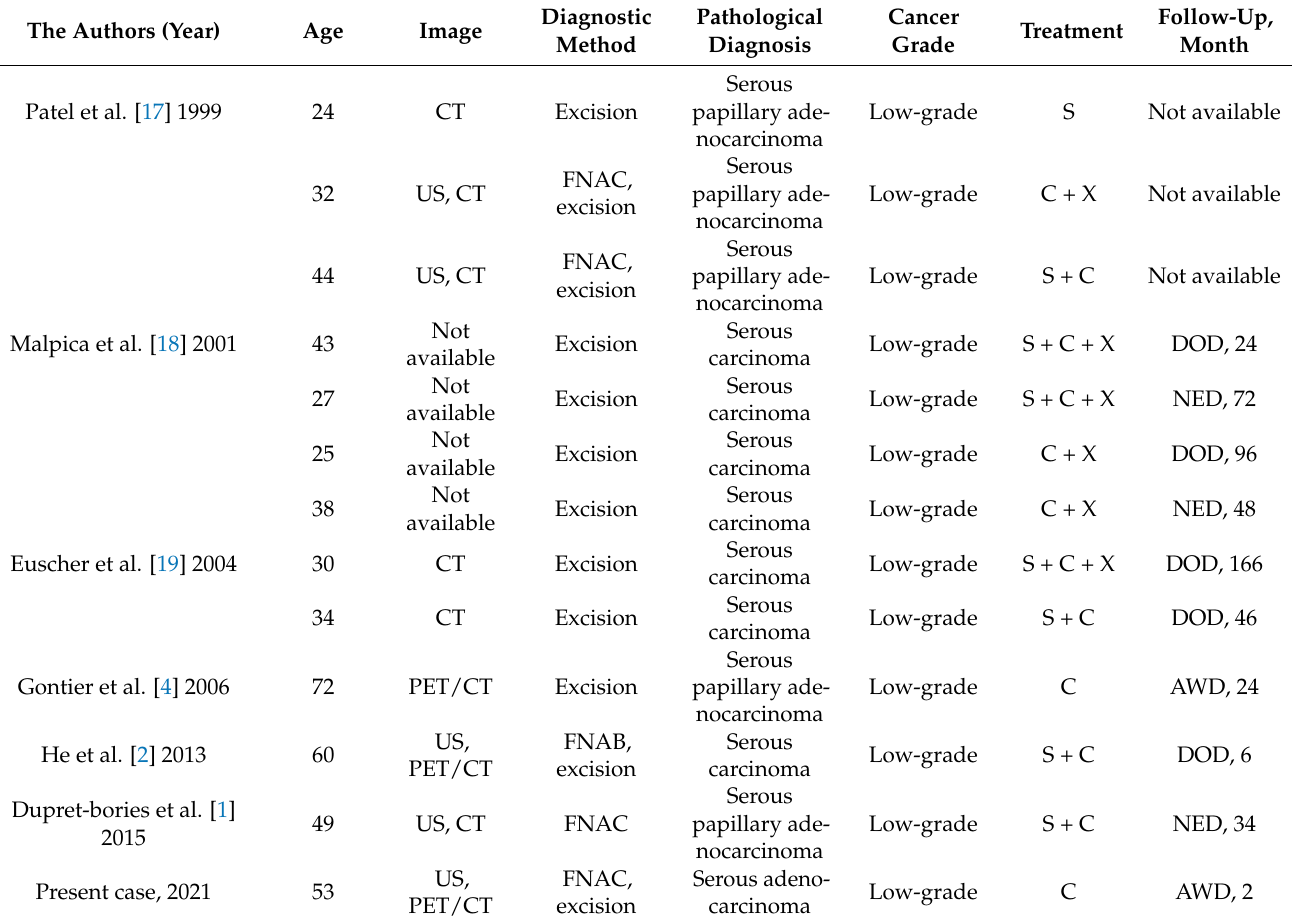
Table 1. Reported cases of low-grade ovarian serous tumor with neck